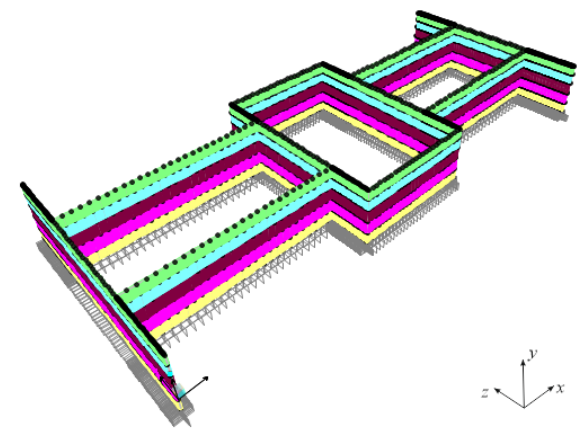
Figure 12. Overview of the finite element global homogenized